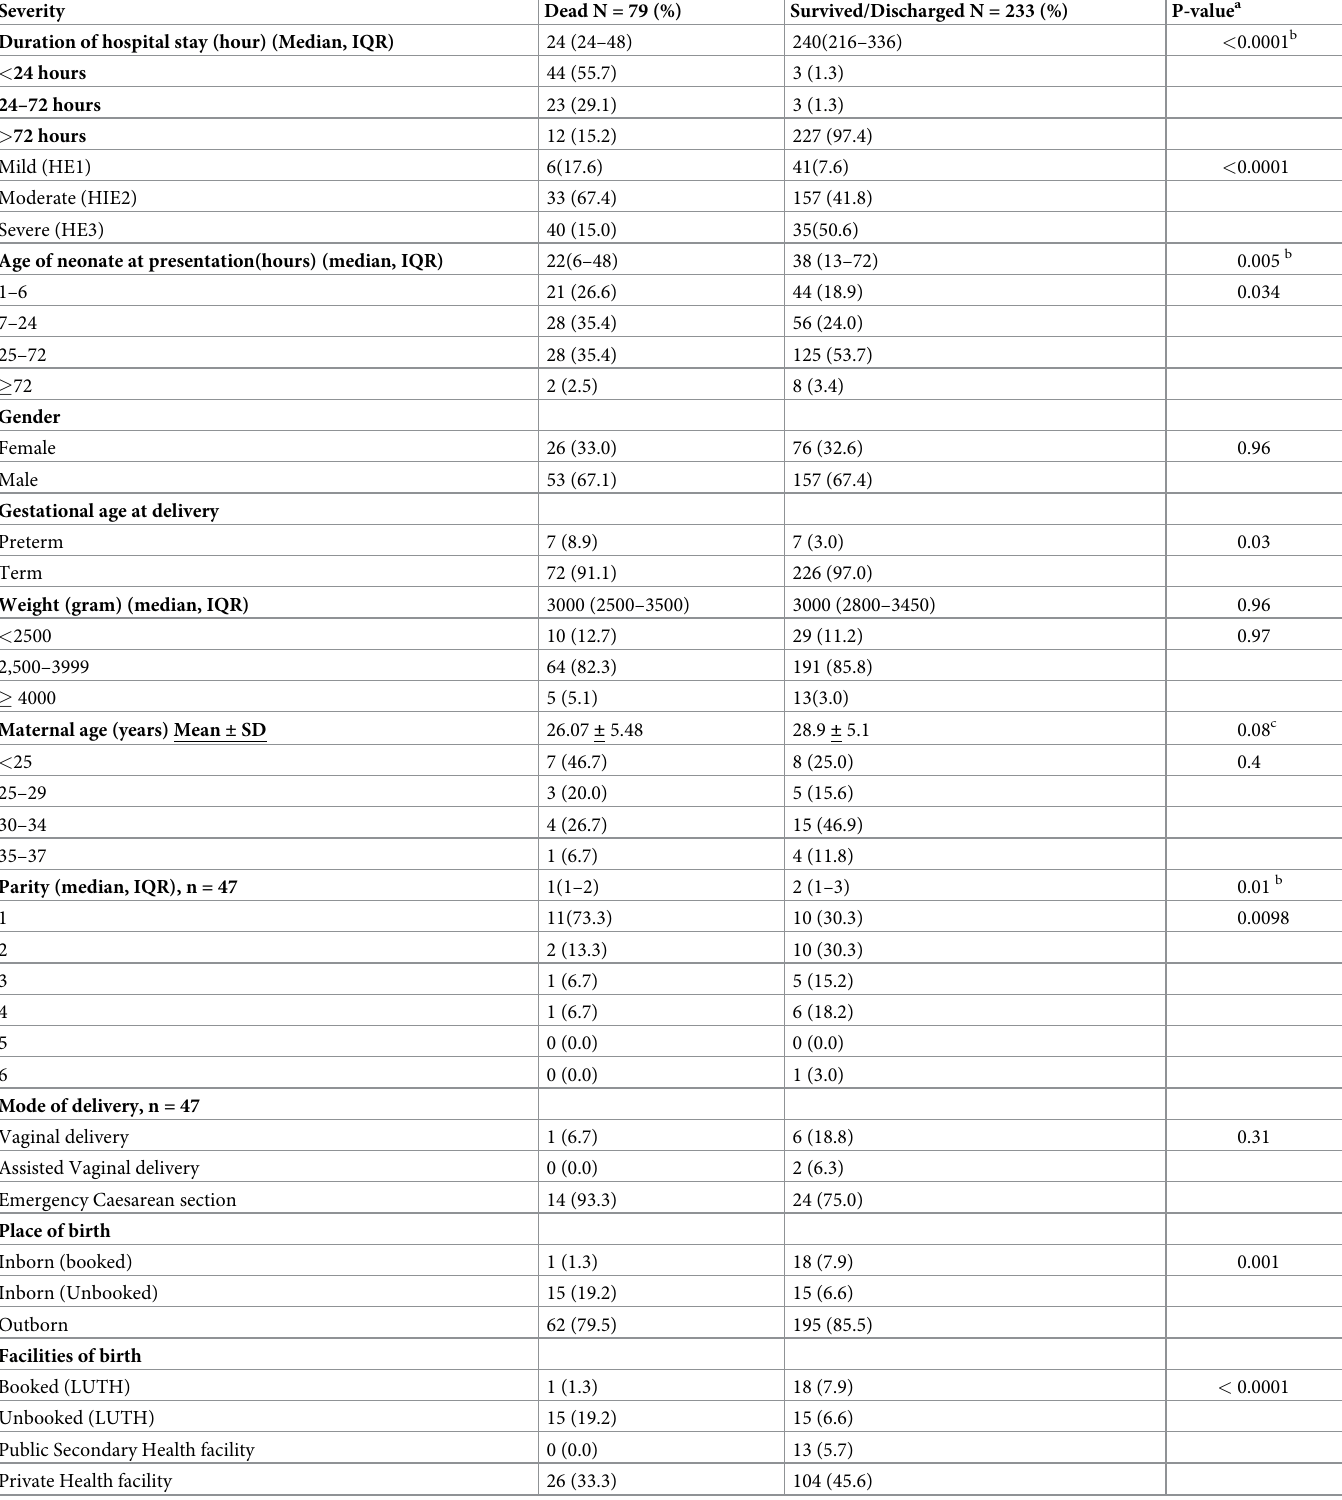
Table 5. Association between survival of HIE babies and maternal/neonatal